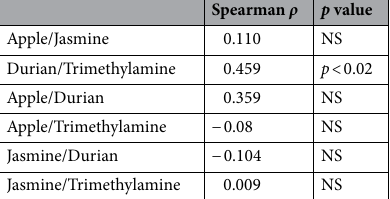
Table 3. Spearman correlations between OHR at IDT. Significant results were considered for p < 0.05. Non- significant results are noted as